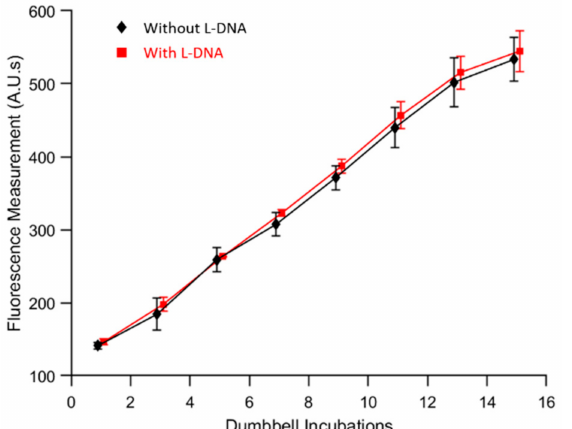
Figure 7. Comparison of D-DNA amplification with (red) and without (black) parallel L-DNA dumbbells included. The mean of three trials ± one standard deviation is shown.